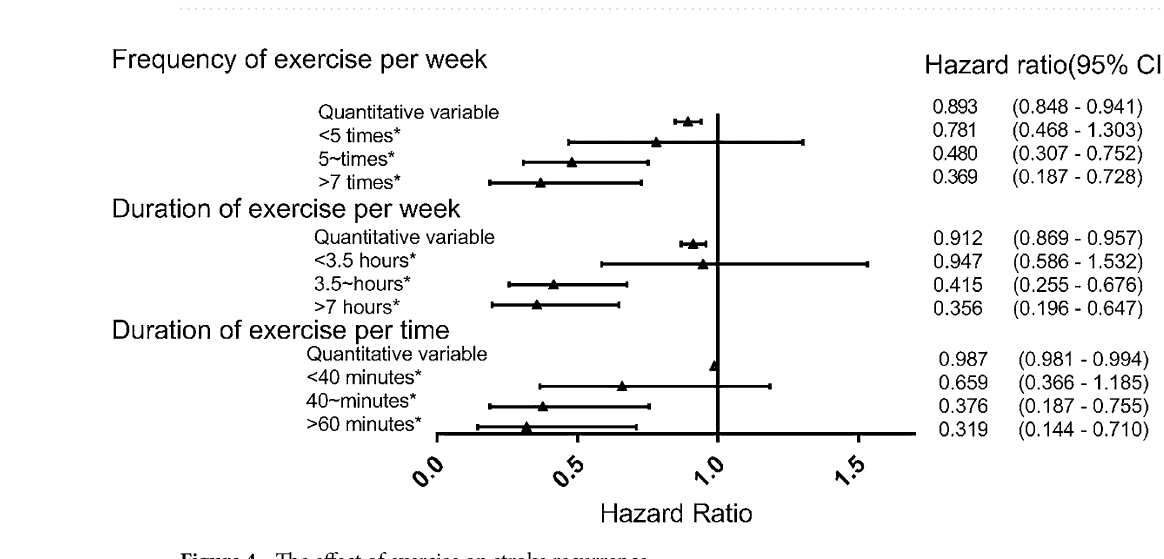
Figure 3. Survival curve of stroke survivor for different physical exercise characteristics.